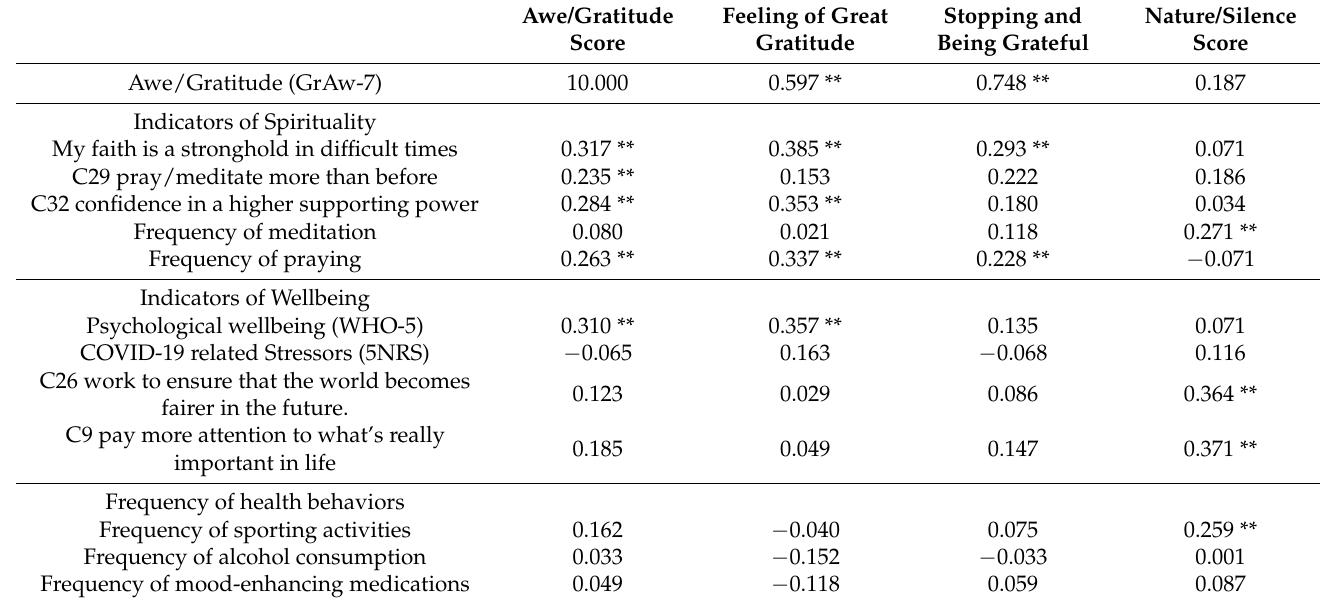
Table 4. Experience of Awe/Gratitude and Nature/Silence in